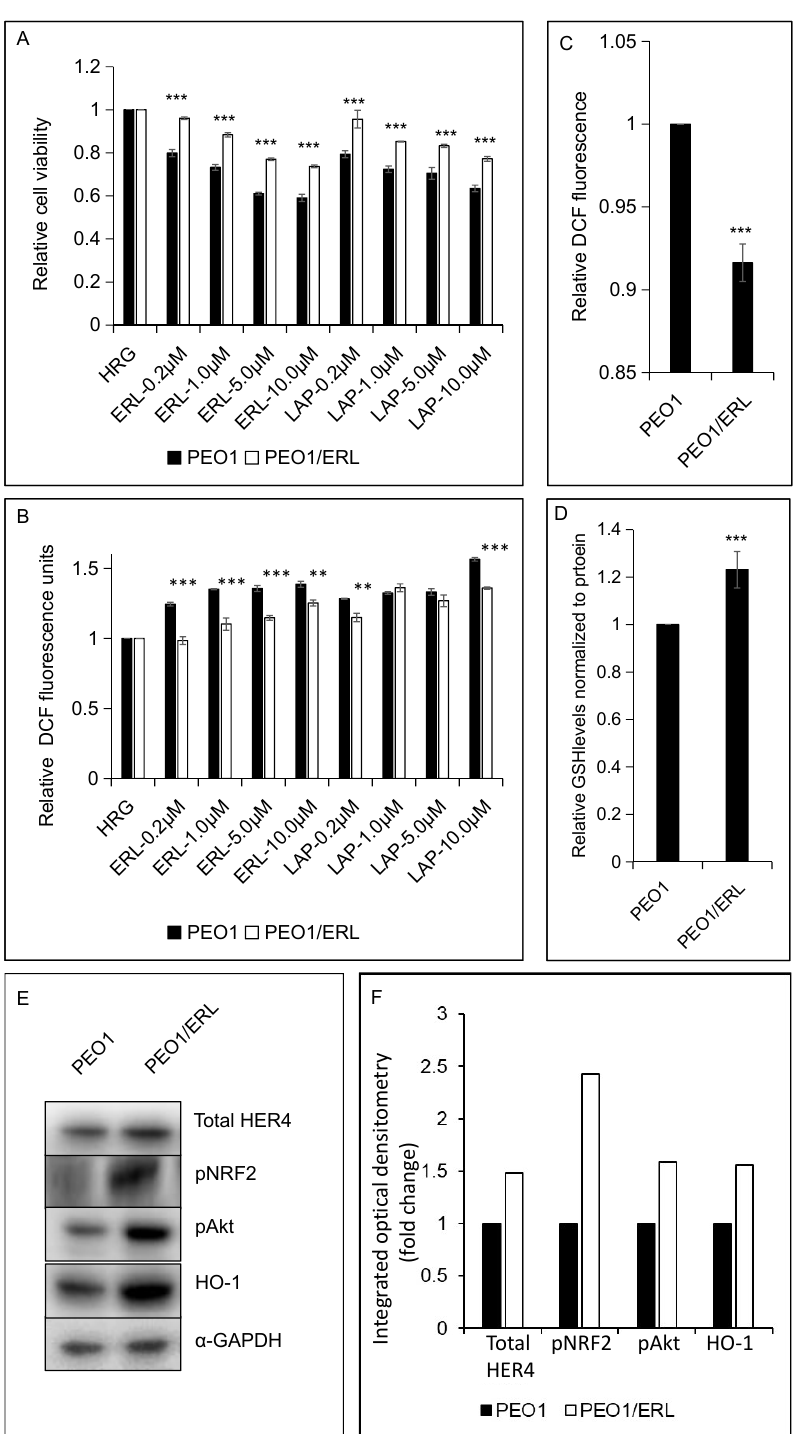
Figure 5. ERL resistant PEO1 (PEO1/ERL) ovarian cancer cell line showing (A and B) increased survival to ERL and cross- resistance to LAP; (C and D) decreased basal ROS and increased basal GSH levels; and (E and F) increased basal HER4, pNRF2, pAkt and NRF2-dependent HO-1 levels relative to the parental PEO1 cell line. The bar charts (A-D) indicate the expression levels as fold change. Data shown are the mean ± SD of triplicates, normalized to control and expressed as fold change with statistical significance determined by student’s t -test (**: P < 0.01 and ***: P <